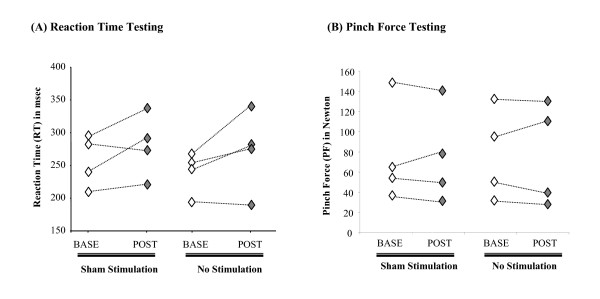
(A) Effects of Sham stimulation on RT compared to No stimulation. Reaction times were comparable during Sham stimulation and No stimulation with slight slowing of reaction times during POST compared to BASE. (B) Effects of Sham stimulation on PF compared to No stimulation Forces were comparable during Sham stimulation and No stimulation with slight decrease of pinch force during POST compared to BASE.